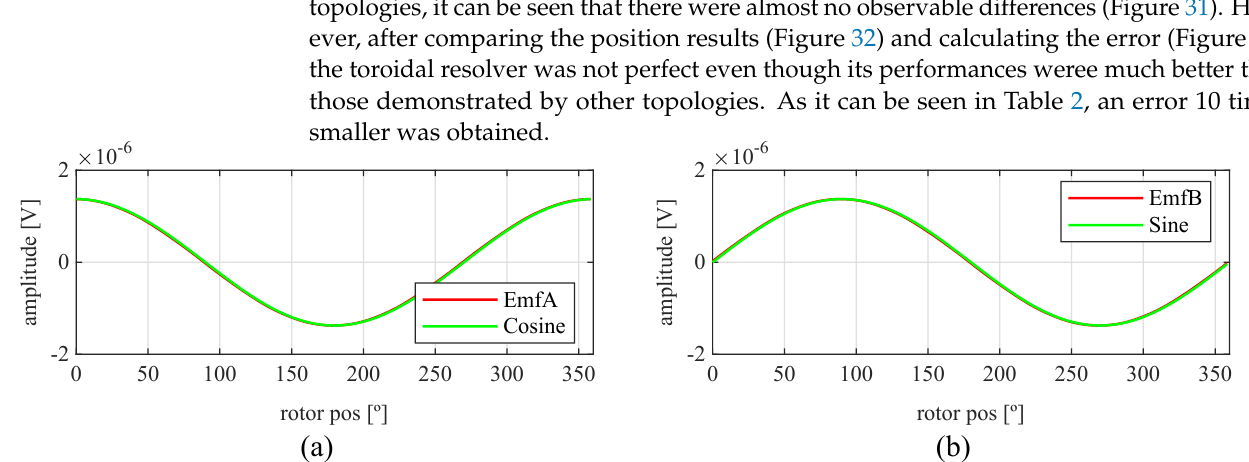
smaller was obtained.